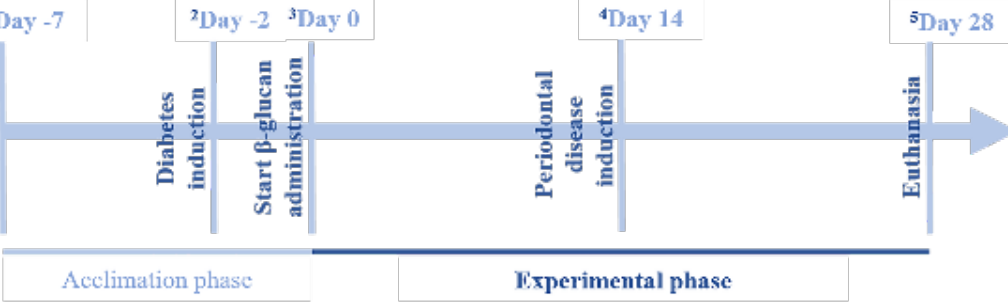
Figure 1. Schematic representation of the experimental design across time. 1 All animals were acclimated in individual metabolic cages for seven days; 2 Diabetes induction (80 mg/kg of streptozotocin) for animals in the following groups: diabetes, diabetes + periodontal disease, diabetes + β -glucan, diabetes + periodontal disease + β -glucan; 3 Start of experimental period-start of β -glucan administration for animals in the following groups: β -glucan, diabetes + β -glucan, periodontal disease + β -glucan, diabetes + periodontal disease + β -glucan; 4 Periodontal disease induction (by ligature protocol) for animals in the following groups: periodontal disease, diabetes + periodontal disease, periodontal disease + β -glucan, diabetes + periodontal disease + β -glucan; 5 Euthanasia-collection of blood and tissue samples and removal of the jaws.